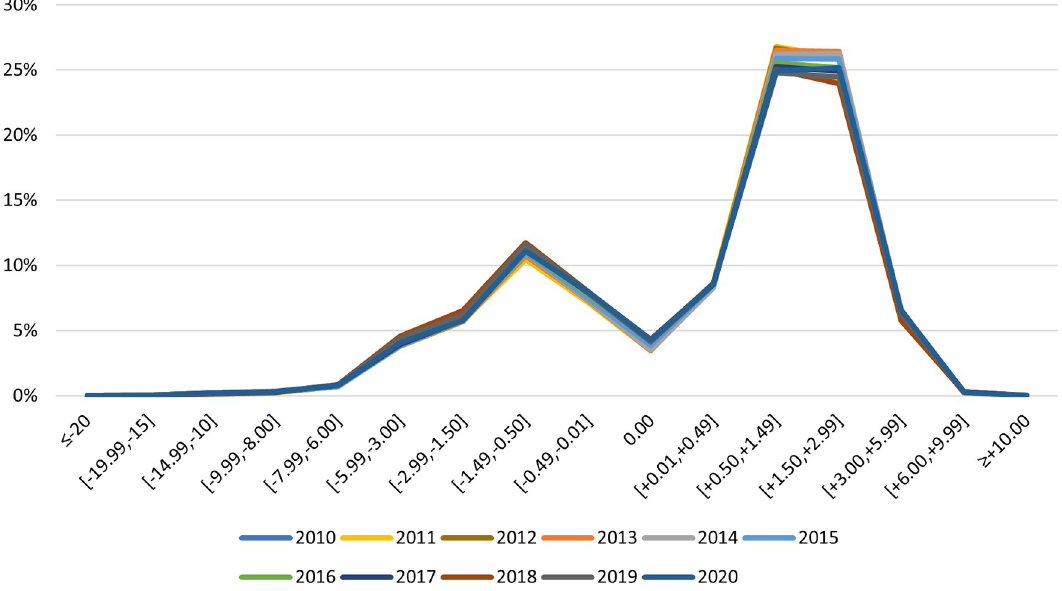
Fig 3. Distribution of ophthalmic prescriptions in Portugal from 2010 to